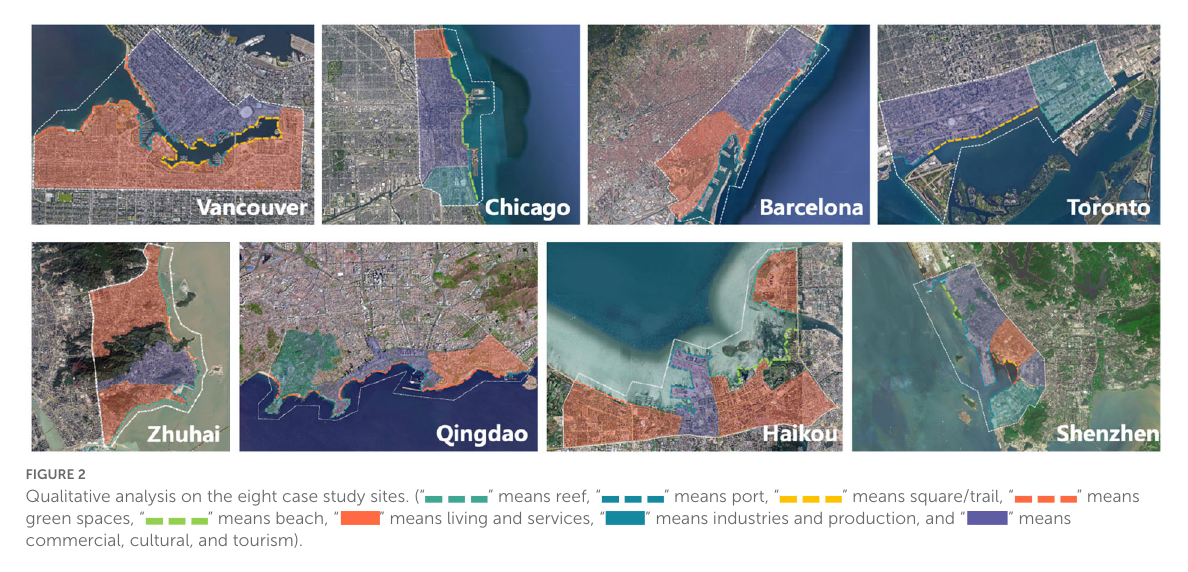
FIGURE2 Qualitative analysis on the eight case study sites. (“ ” means reef, “ ” means port, “ ” means square/trail, “ ” means green spaces, “ ” means beach, “ ” means living and services, “ ” means industries and production, and “ ” means commercial, cultural, and